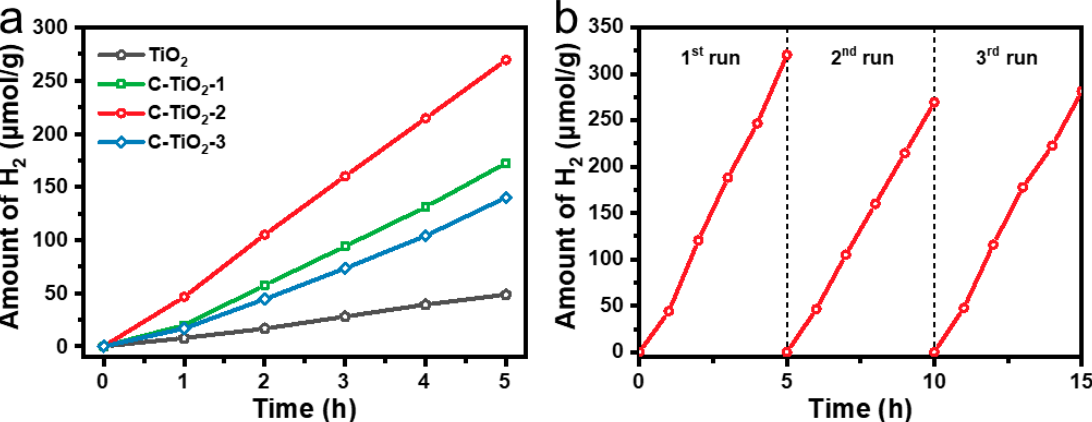
Figure 6. ( a ) Photocatalytic hydrogen evolution under simulated solar light irradiation over different samples. ( b ) Cycling tests of photocatalytic hydrogen evolution of the C–TiO 2 –2 photocatalysts under simulated solar light irradiation (methanol as a sacrificial